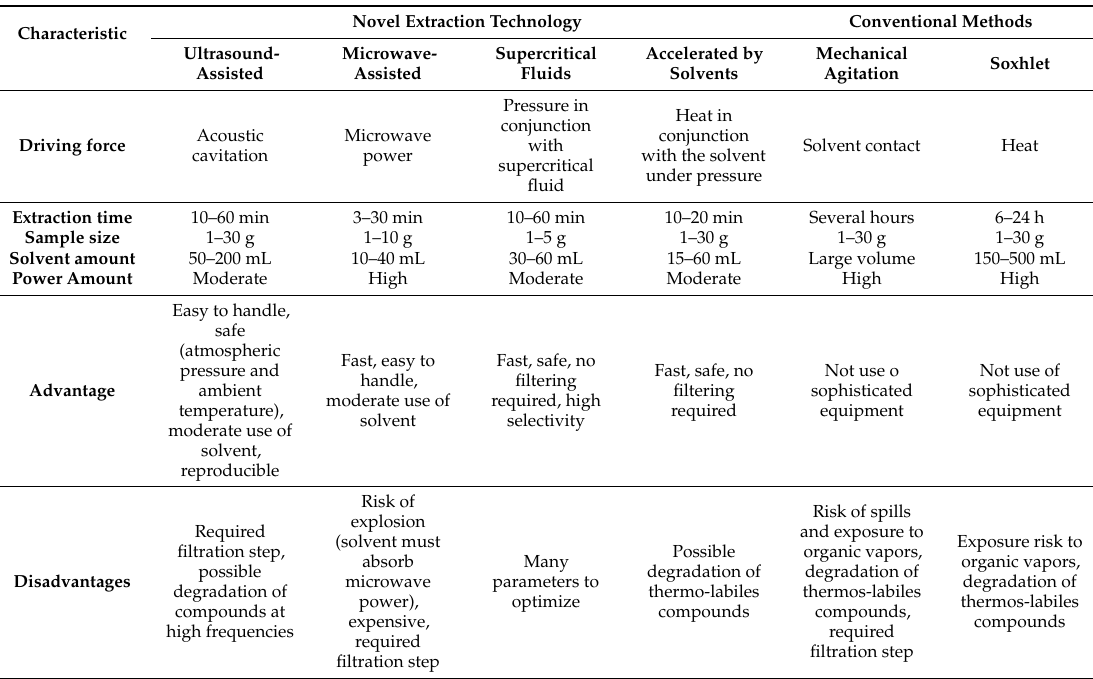
Table 1. Main characteristics, advantages and disadvantages of novel and conventional extraction technologies